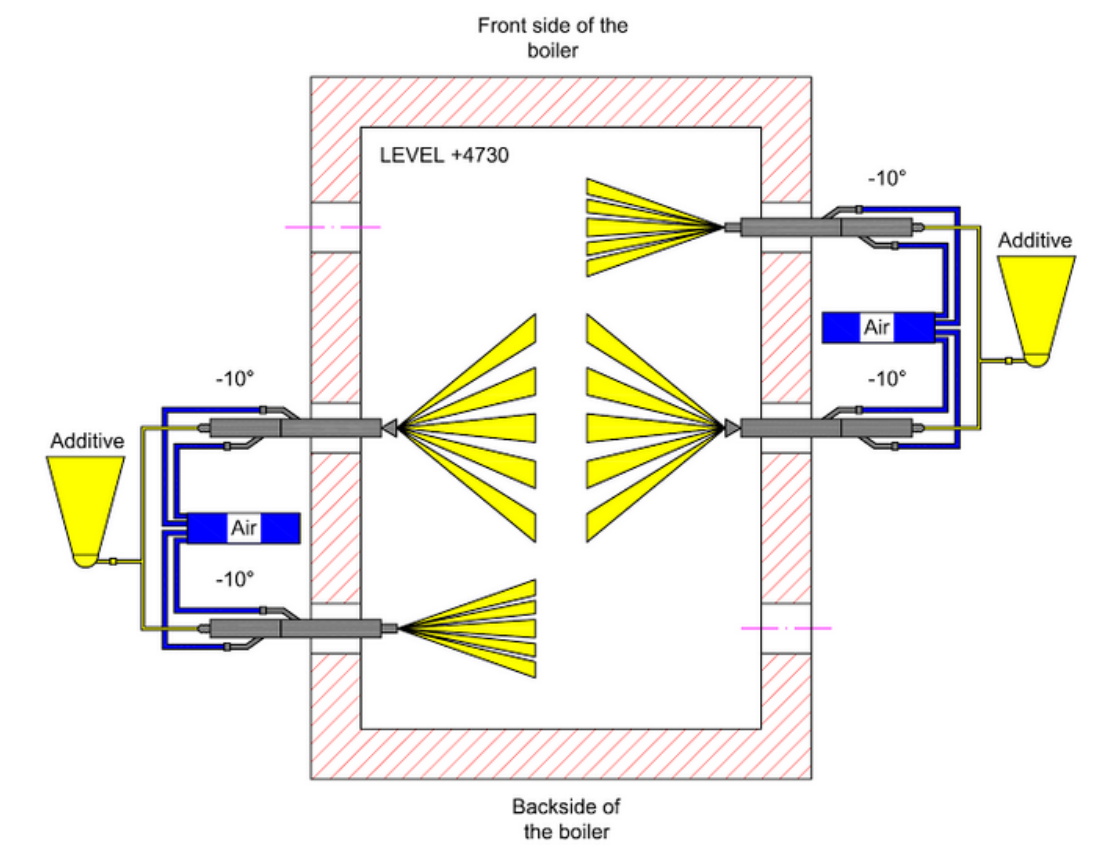
Figure 3. Block diagram of the injection system.